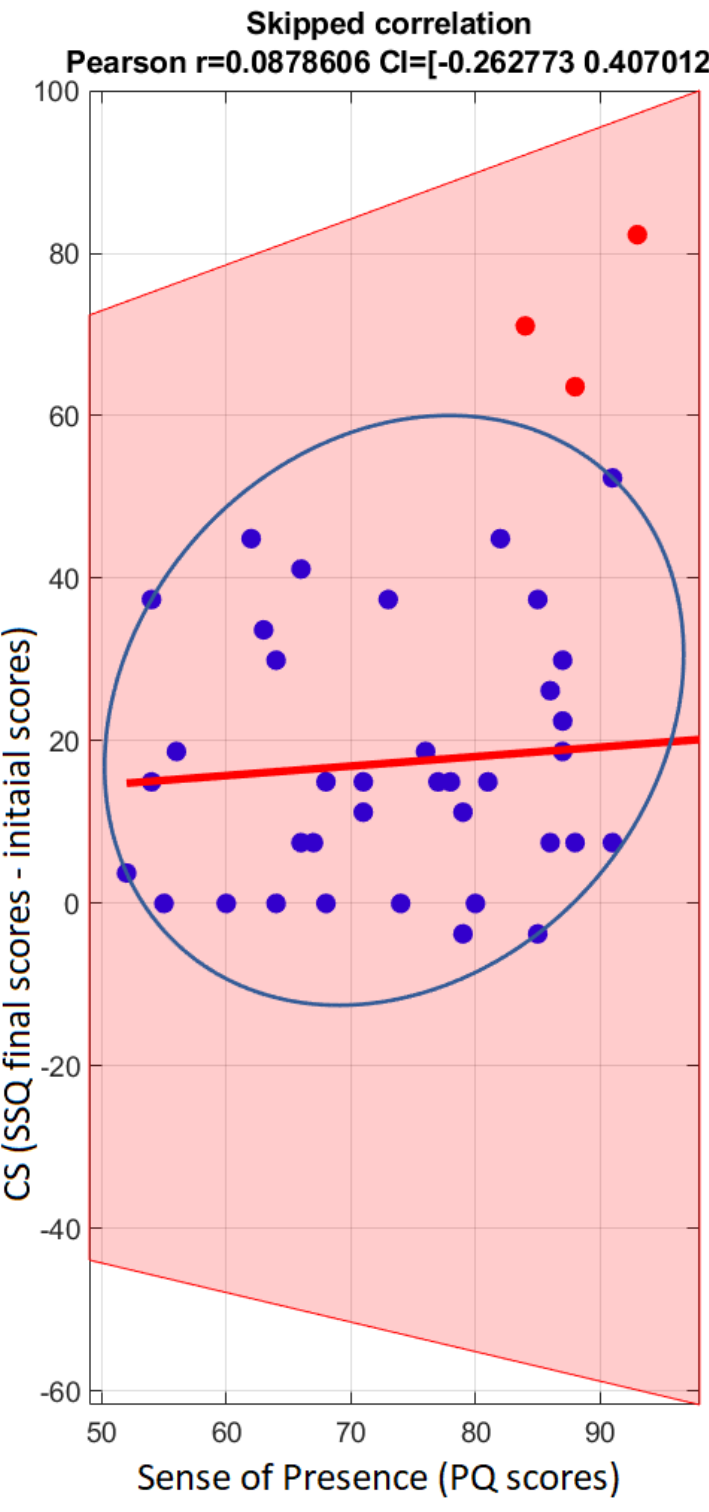
Figure 4. Skipped correlations between SSQ and the PQ. The x -axis represents PQ scores, and the y -axis shows SSQ total scores (final score minus score before the start of the experiment). The top of the figure shows Pearson’s r coefficients and 95% confidence intervals (shown as the transparent red area in the figure). Dots show each data point. The red line represents the correlation coefficient, and the blue line represents the distances from the orthogonal center of the data where data points outside are